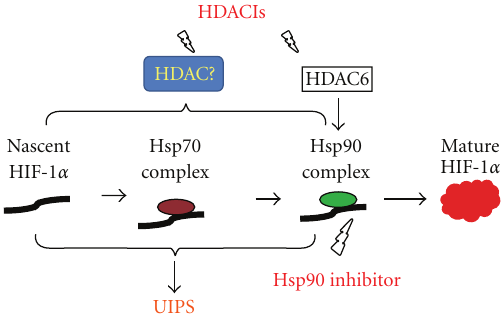
Figure 4: Acetylated Proteins Potentially Involved in the Control of HIF-1 α Maturation and Stability. HDACIs may lead to hyperacetylation of one or more proteins involved in the folding process of HIF-1 α . Similar to HSP90 inhibition-caused blockage of normal folding and mature processes of HIF-1 α , unfolded or misfolded HIF-1 α remains interacting with HSP70, which may eventually trigger a ubiquitination- independent degradation